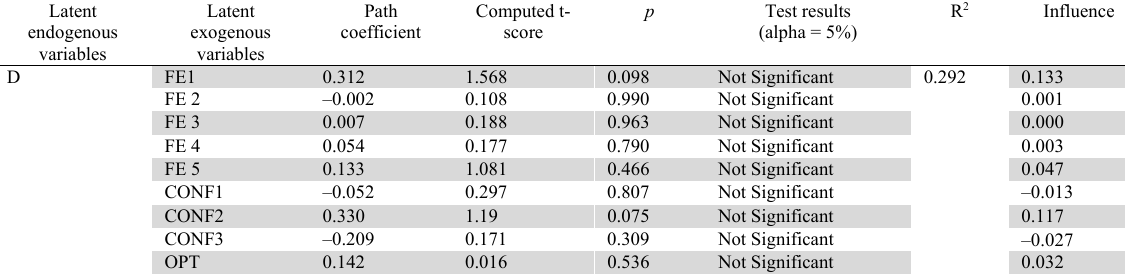
Summary of Hypothesis Testing on Model